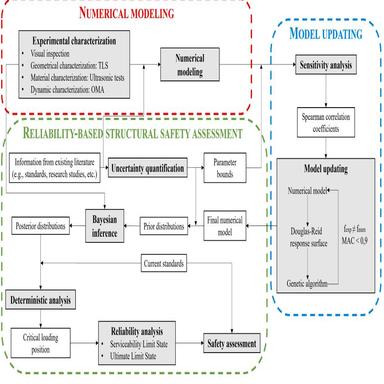
Flowchart of the proposed methodology.